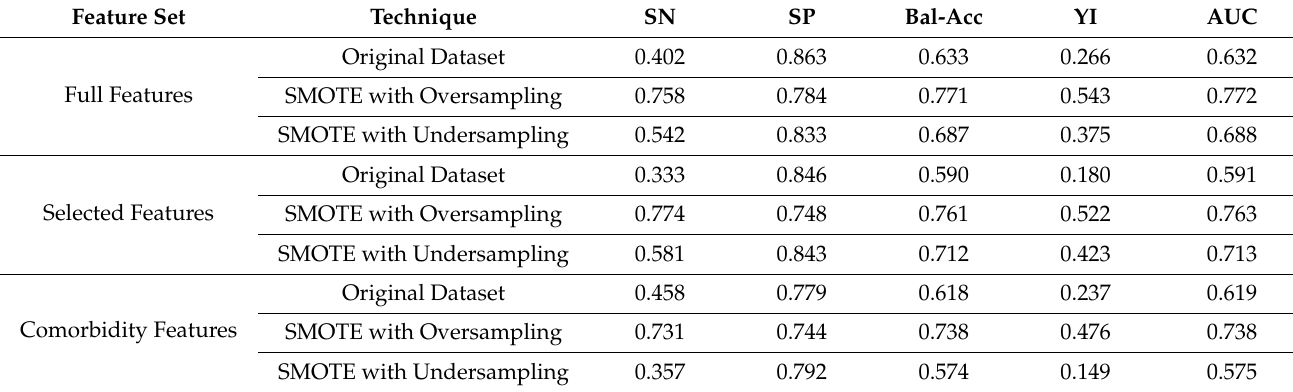
Table A3. Case 3—Decision Tree (Multiclass, No_Ventilator:0, NIV:1,